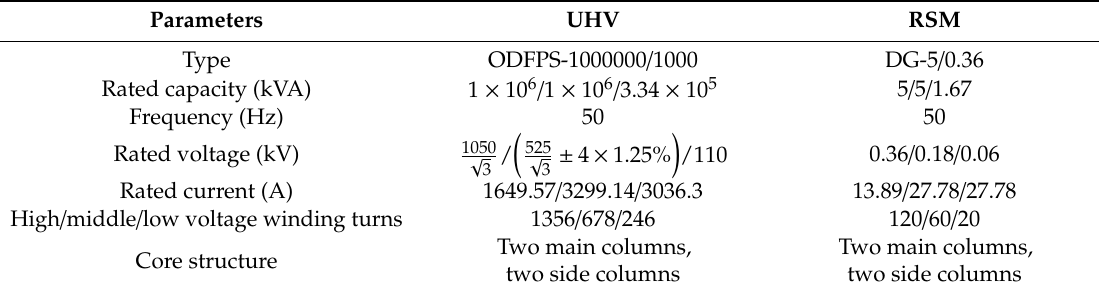
Table 2. Parameters of the ultra-high voltage (UHV) transformer and reduced scale model